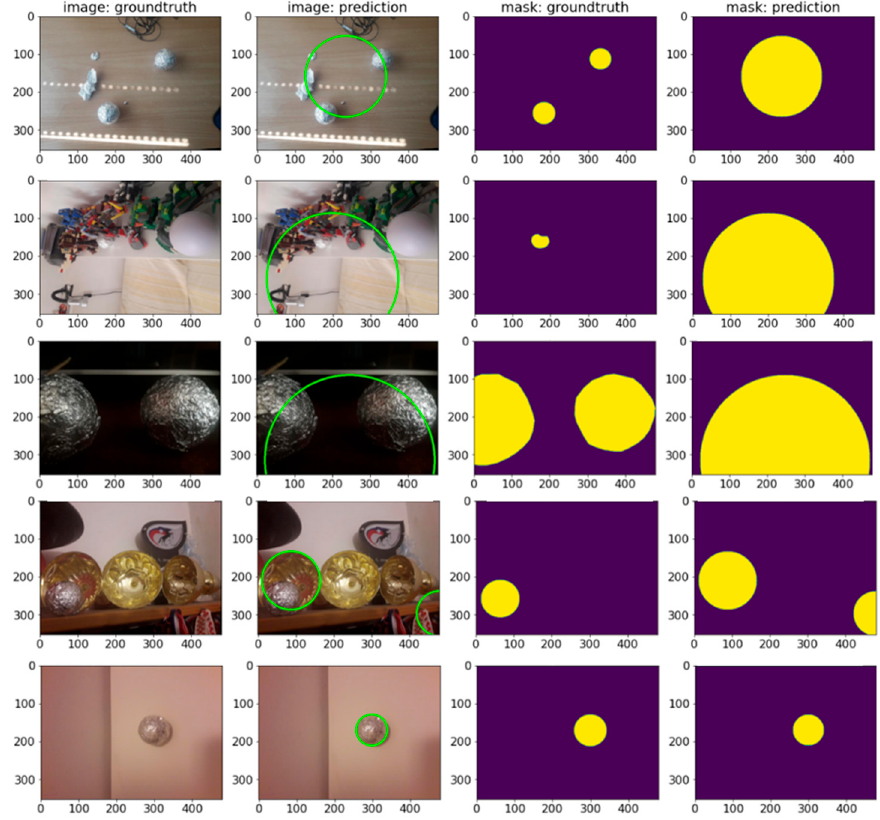
Figure 10. The Hough transform parameters’ (Hough 50-40-50) combination predictions. From left to right: original input image, input image with detected circles, ground truth mask and model’s prediction.